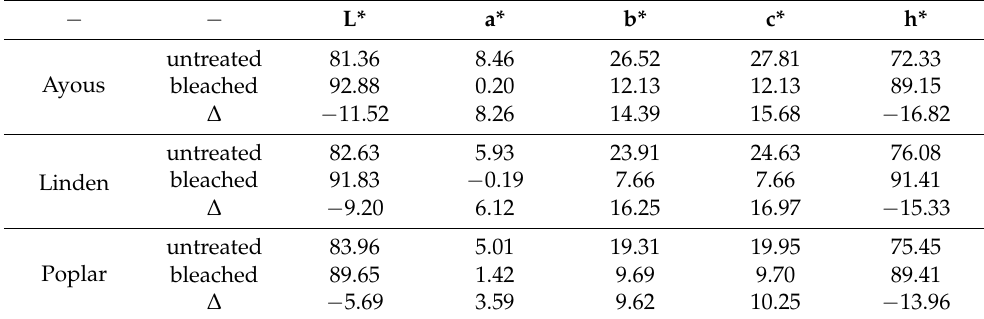
Table 2. Color depth values of the